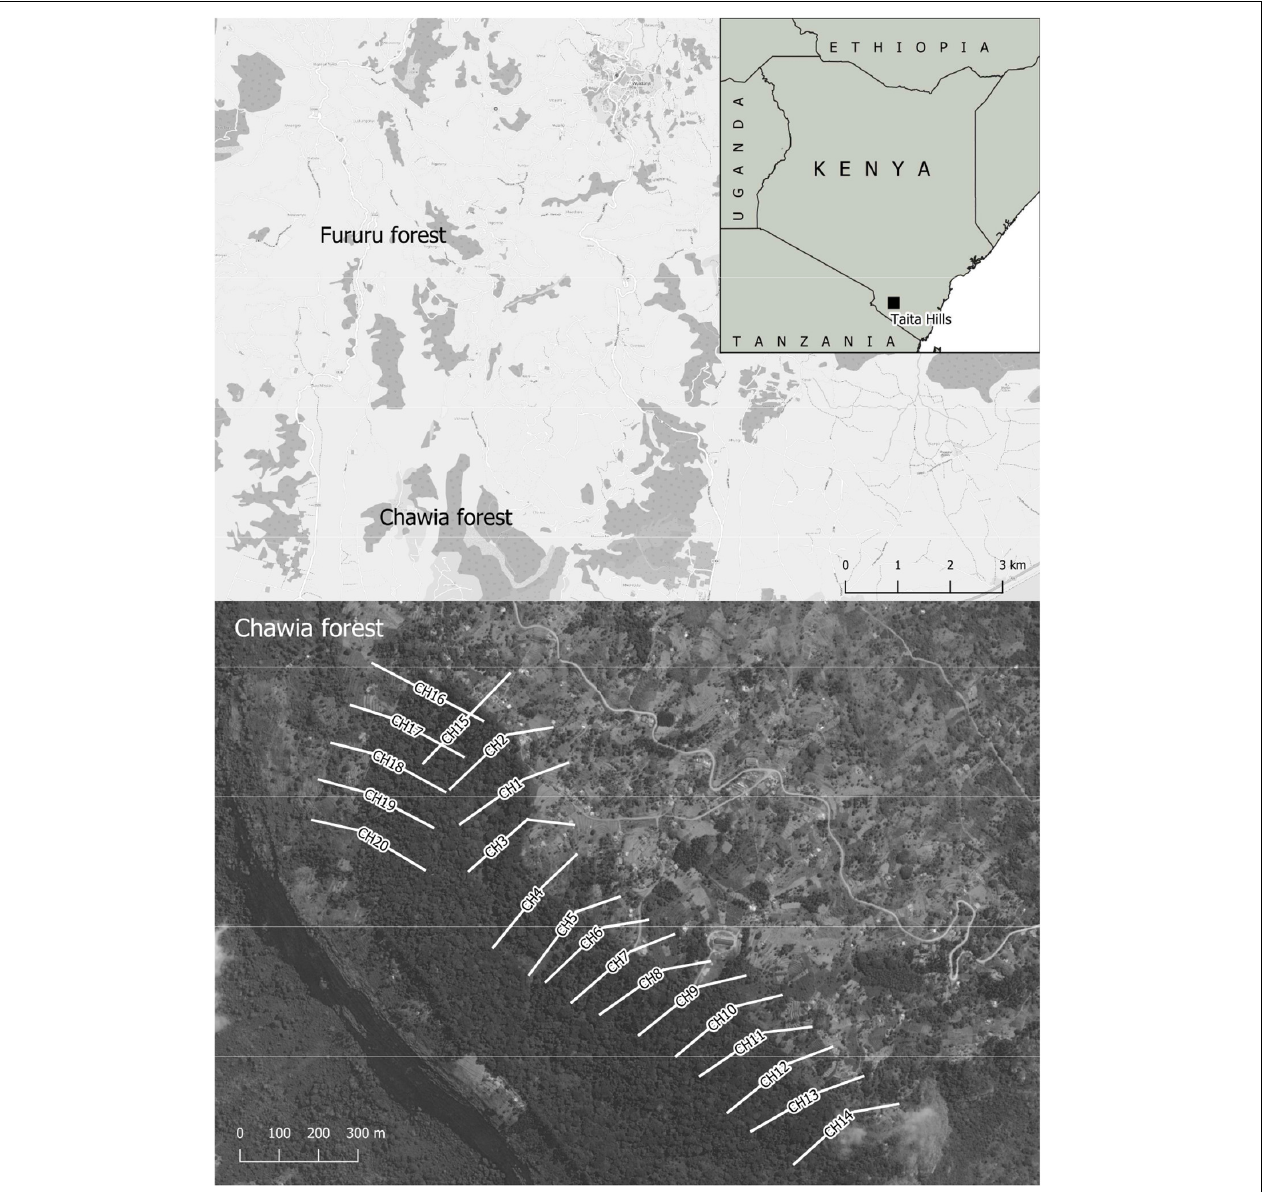
FIGURE 1 | The Taita Hills study area in Kenya (small inlet map), with the two forest patches, Fururu forest (plantation) and Chawia cloud forest, surrounded by open agricultural land. Gradients are shown in the large map